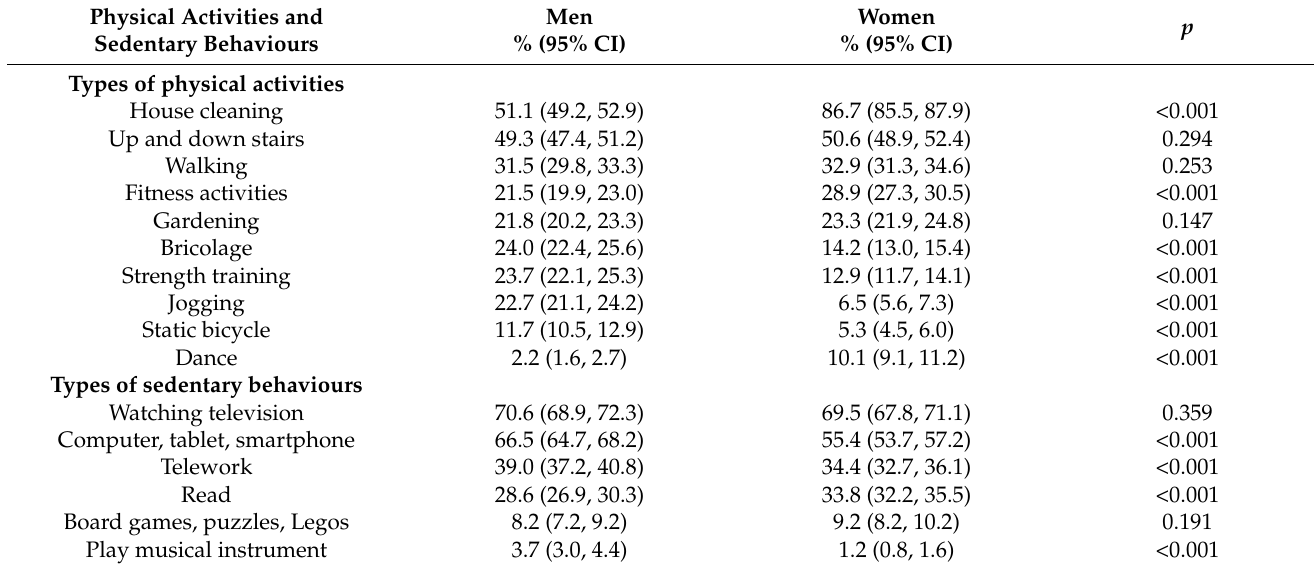
Table 3. Physical activities and sedentary behaviours, during the COVID-19 social